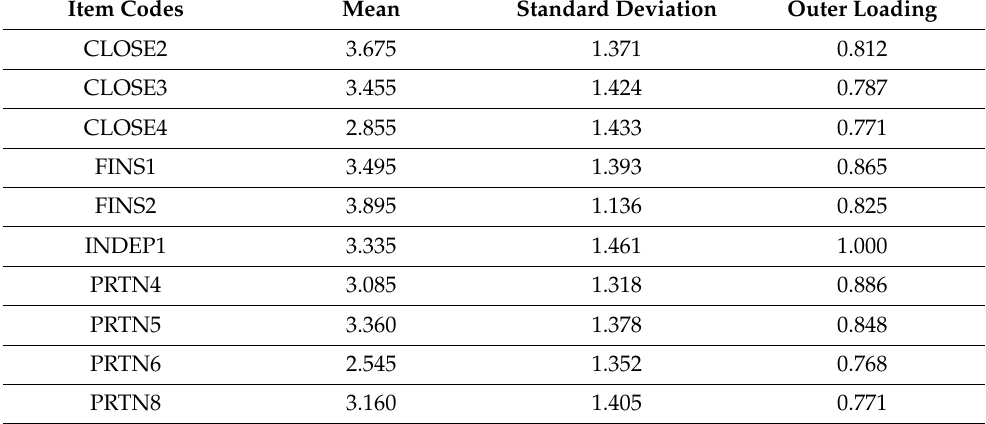
Table 9. Descriptive statistics of the items in the